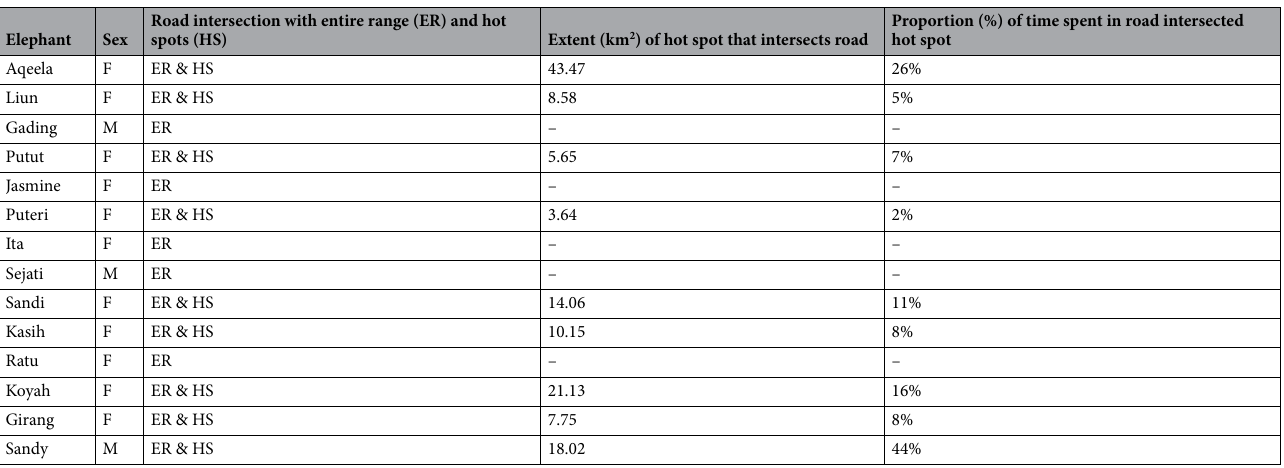
Table 4. Occurrence of hot spot intersection with the main road or planned road/highway, along with the hot spot extent and proportion of time spent within that hot spot.